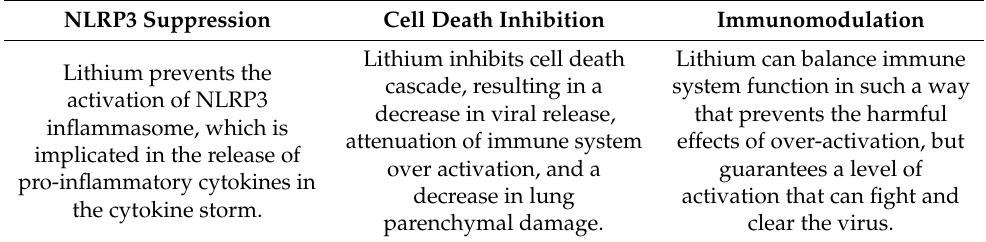
Table 1. Summary of the therapeutic effects of lithium for COVID-19 via membrane